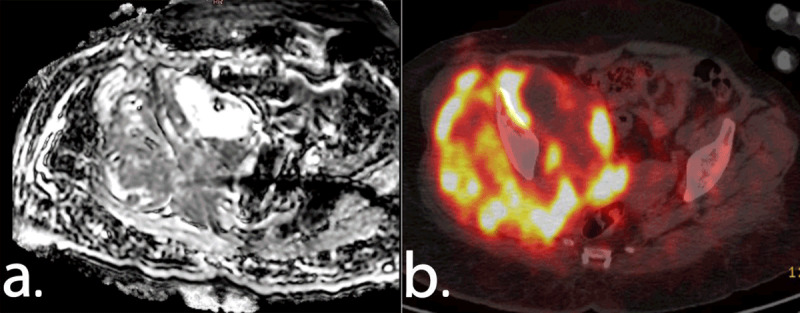
DWI (a) and FDG-PET/CT (b) images of a 51-year-old female with a soft tissue mass in the right iliac fossa. ADCmean, ADCmin and SUVmax of the lesion were 0.97 × 10–3mm2/s, 0.60 × 10–3mm2/s and 13.61, respectively. The lesion was diagnosed as high grade leiomyosarcoma after core needle biopsy.